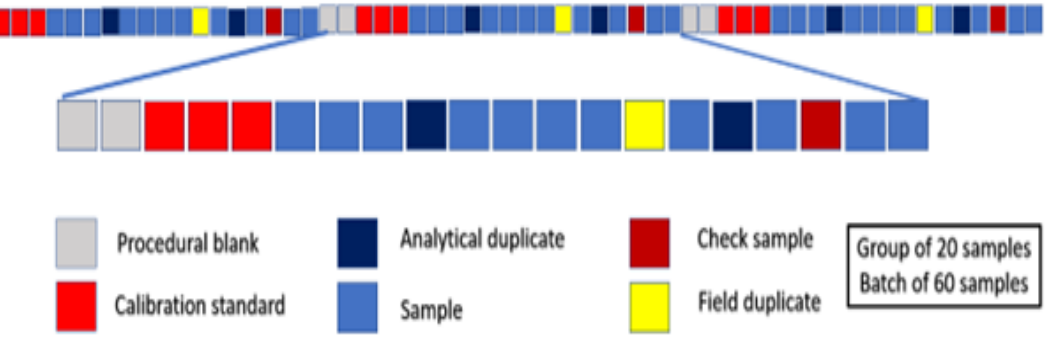
Figure 3. Typical analytical sequence of a batch of samples including duplicates, procedural, and calibration standards.